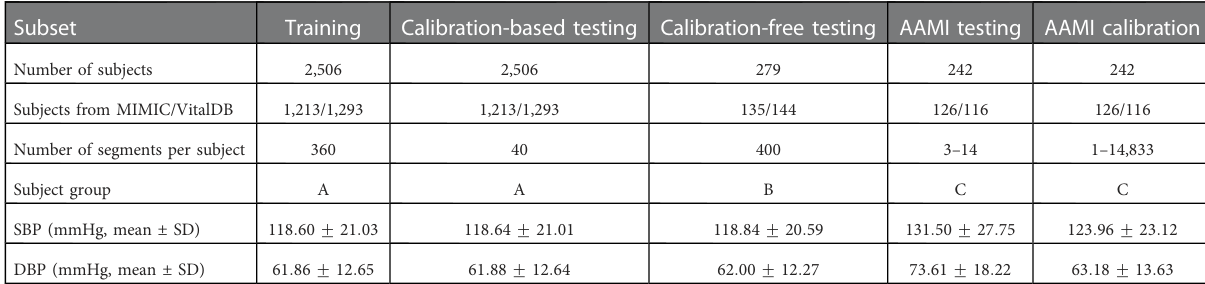
TABLE 4 Summary of statistical information of the training, calibration, and testing sets generated from the PulseDB dataset.